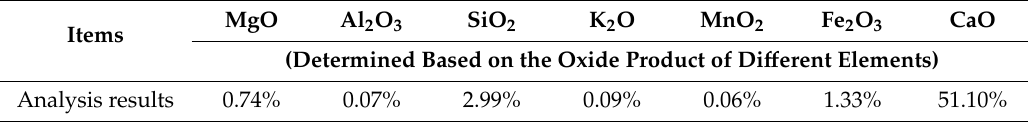
Figure 6. SEM image of the particles discharged from the system. Table 2. Composition analysis results of the particles generated by the CFPB.